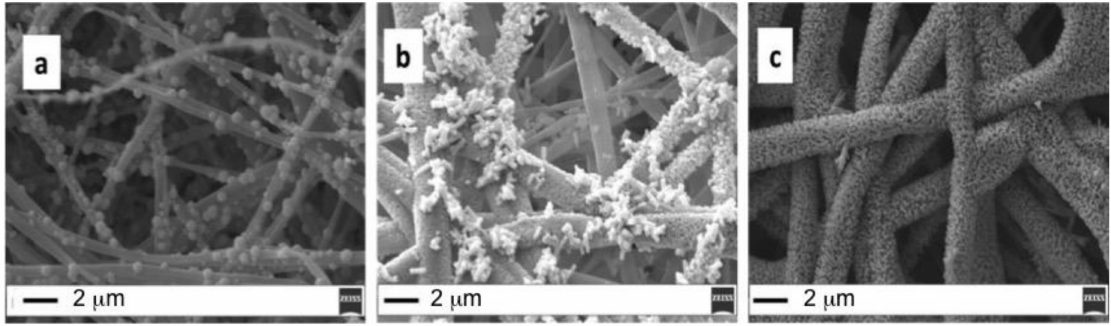
Figure 1. ( a ) Seed 1 h, annealing 150 ◦ C 1 h, CBD 1 h; ( b ) Seed 1 h, annealing 150 ◦ C 1 h, CBD 2 hs; ( c